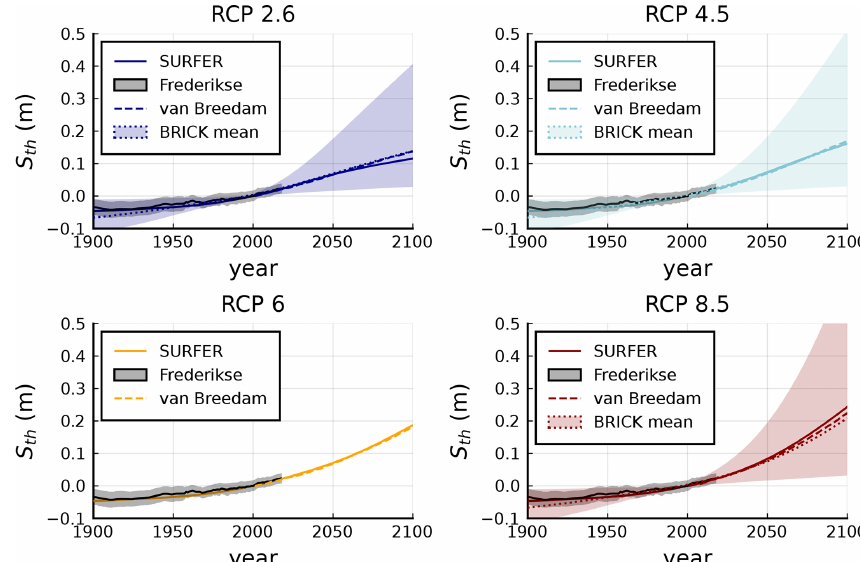
Figure 5. Sea level rise contribution from ocean thermal expansion for historical period and projections along RCP scenarios. SURFER’s estimates correspond to the solid coloured lines and observations for the historical period from Frederikse et al. (2020a) are shown with solid black lines with the corresponding uncertainty range in grey shade. BRICK’s mean and uncertainty range are shown with dotted lines and coloured shades. The dashed lines correspond to results of Van Breedam et al. (2020). Sea level rise is with respect to year 2000.